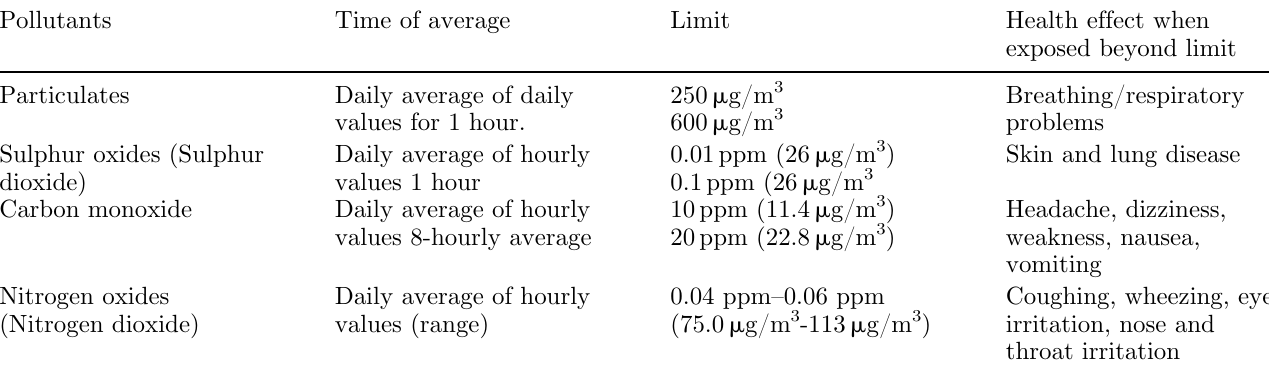
Table 1. Nigerian air quality standards.